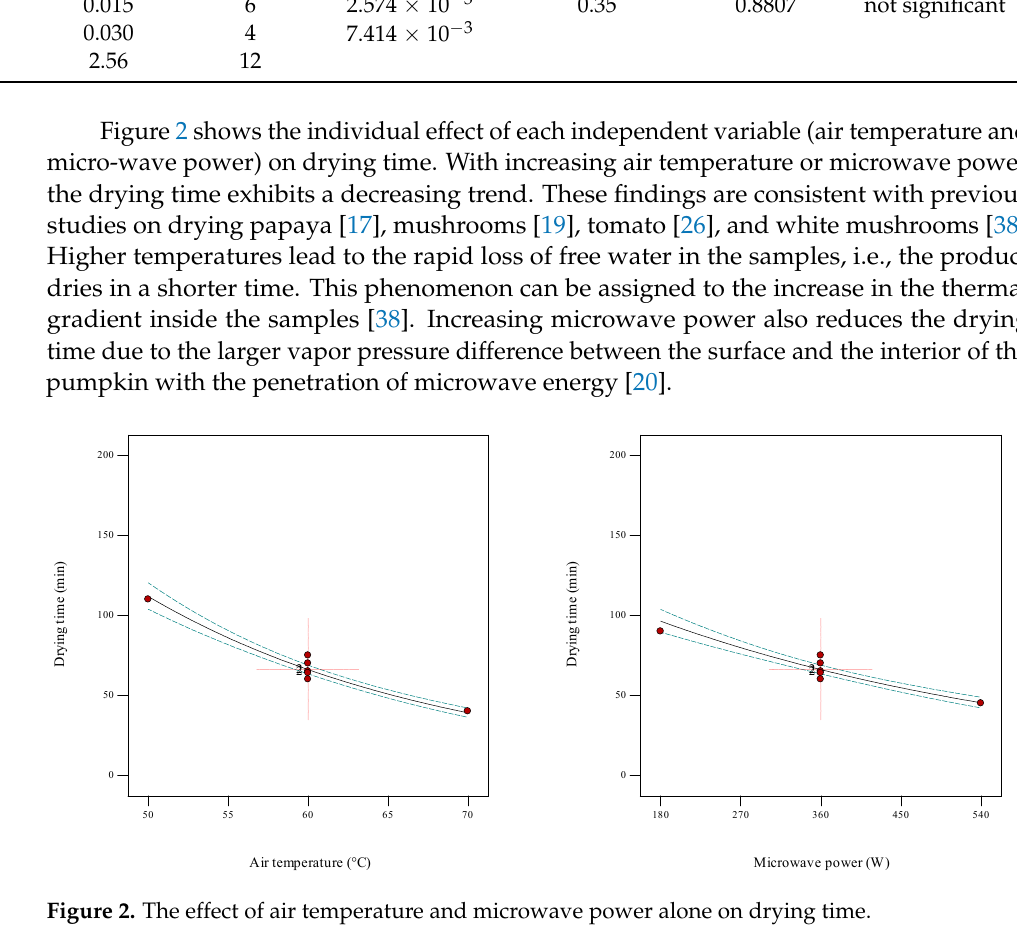
Table 6. Analysis of variance for drying time response using RSM .